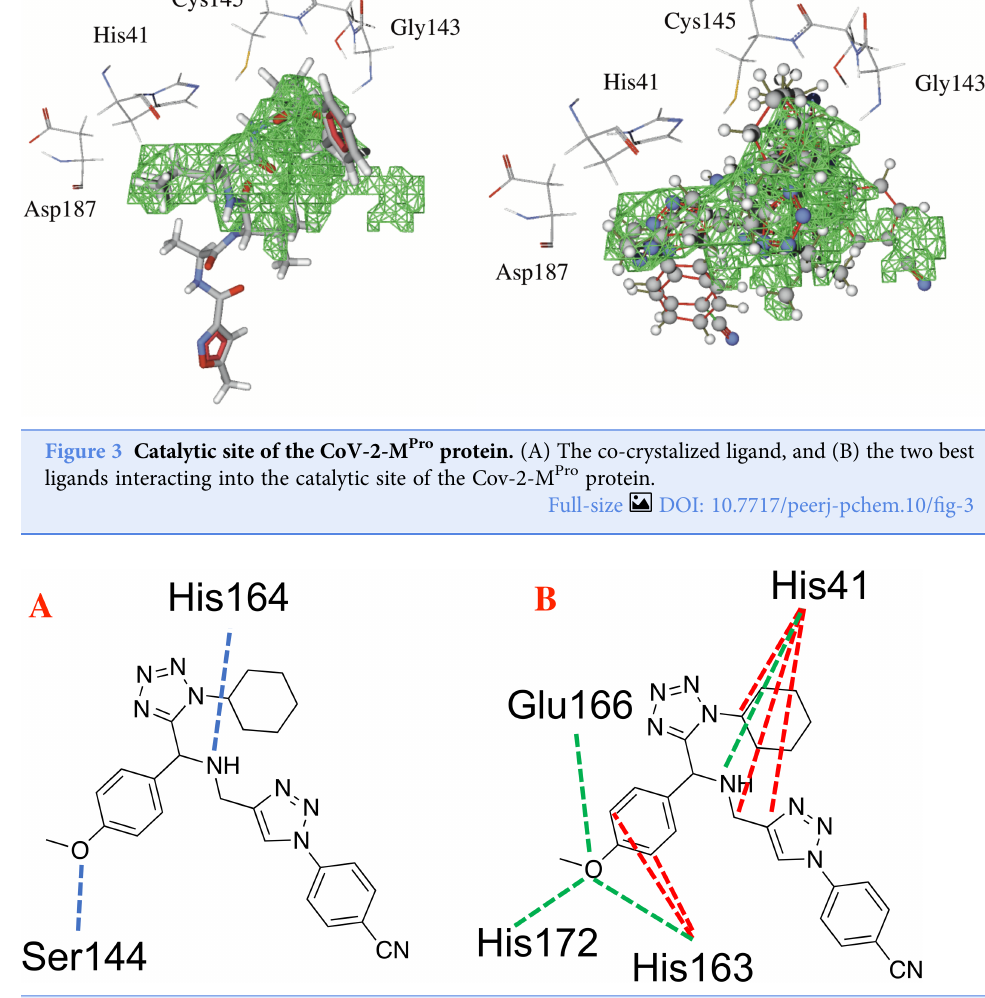
Figure 4 Main non-covalent interactions between the CoV-2-M Pro protein and the best ligand 1e. (A) Hydrogen bond, and (B) electrostatic interactions; Dotted blue lines represent the hydrogen bond interaction, as well as dotted green lines, represent the attractive electrostatic interactions and dotted red lines the repulsive electrostatic